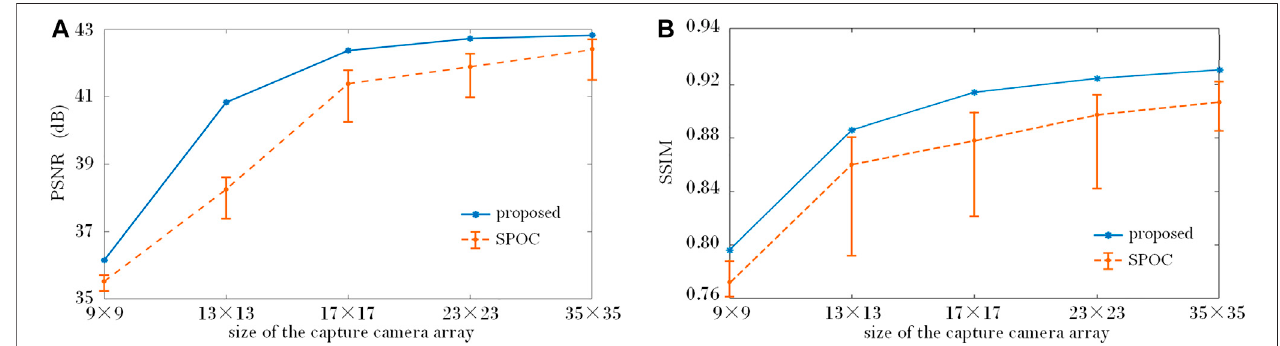
FIGURE11| Thein fl uenceofvariationsincapturecameradensity onimagequalityforgeneratedelements, measured using (A) PSNR and (B) SSIM.Thesolidline indicates the proposed method, the dash line indicates the SPOC method. In the dash line, the upper short segment indicates the reference plane is at 100 mm, the central dot indicates the reference plane is at 80 mm, and the lower short segment indicates the reference plane is at 60 mm.